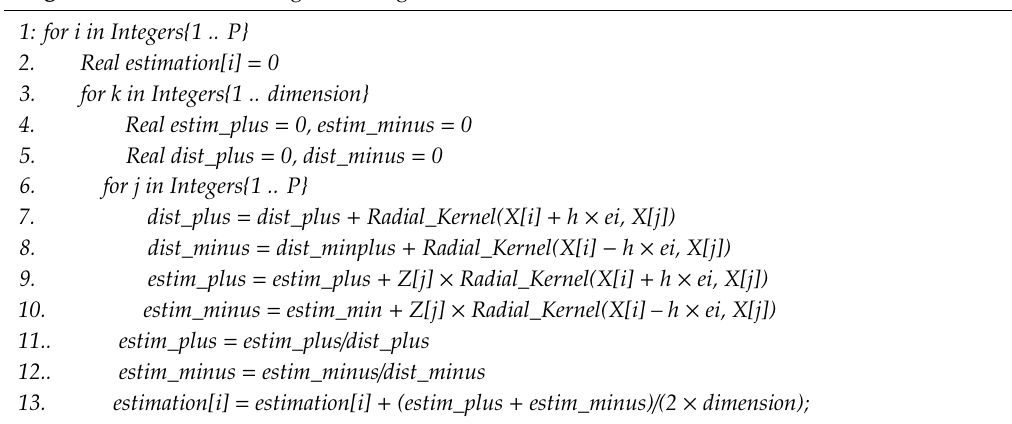
Algorithm 1. Octahedric regression